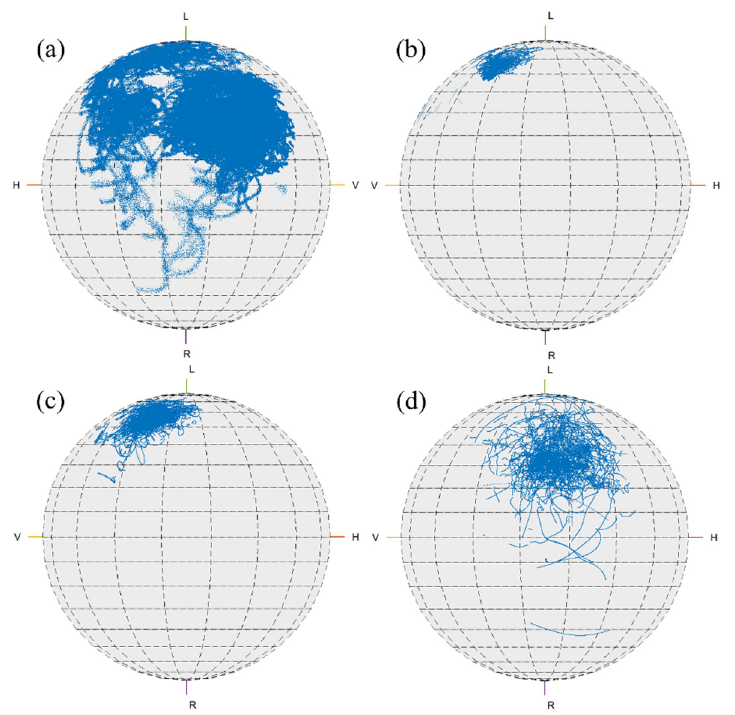
Figure 15. Slovenia beacon: Poincaré sphere representation of measured polarization state for representative samples from each of four days: ( a ) 29 July; ( b ) 15 August; ( c ) 18 August; ( d ) 20 August 2018. Sample rate ( a ): 24,000 samples s − 1 ; ( b – d ): 6000 samples s − 1 . Spheres ( b – d ) rotated to show the ‘rear’ of the sphere (negative tilt angles).